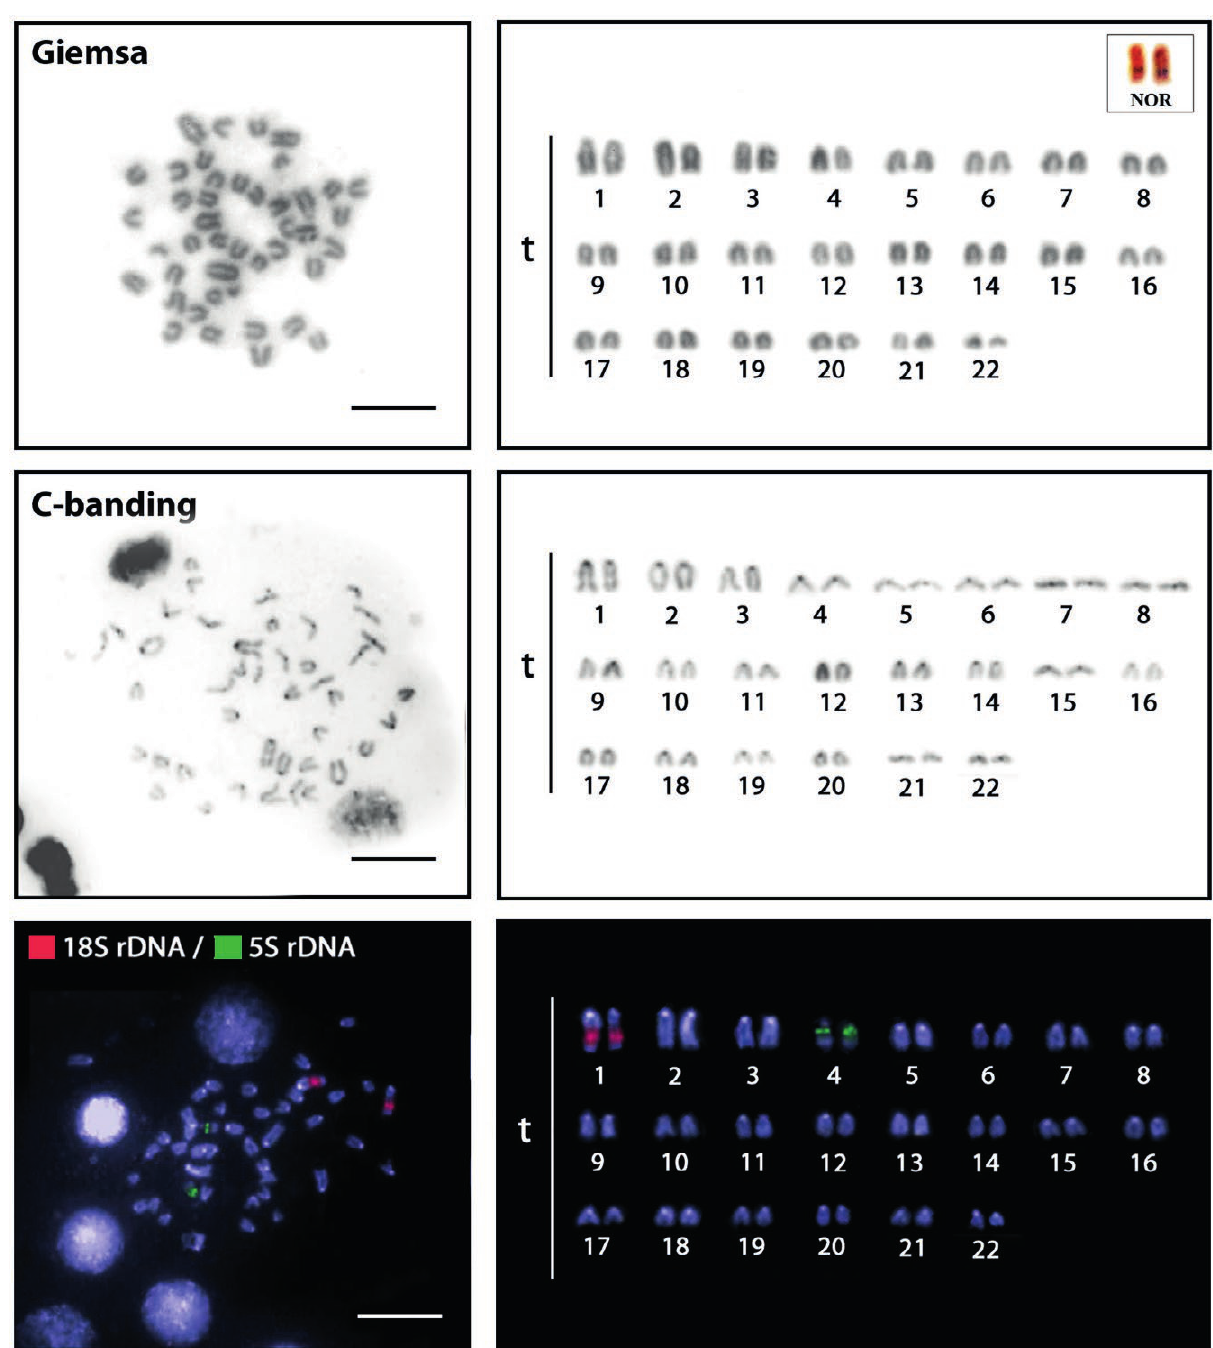
Figure 2. Mataphase and karyotypes of Rhinecanthus aculeatus arranged from conventionally Giemsa-stained, Ag-stained (highlighted in the boxes), C-banded and after fluorescence in situ hybridization with 5S and 18S rDNA probes. Bar 5